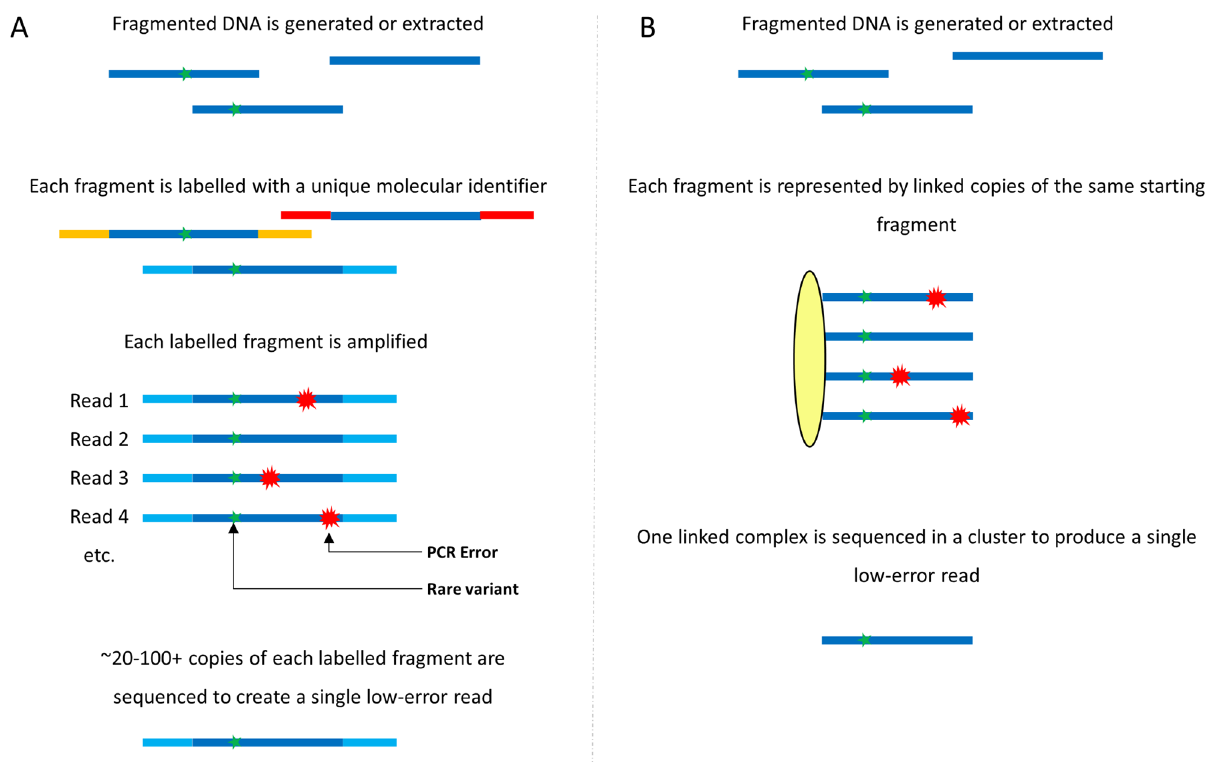
Fig 1. Barcoding vs. Pro-Seq. (A) Common molecular barcoding/UMI methods involve uniquely labeling each DNA molecule with a molecular identifier or barcode. Many copies of each barcoded molecule are sequenced, and reads from individual fragments are collected in software. True variants should be common to every read, while errors should only occur in a smaller fraction of the reads. 20 or more reads are often required to generate a software consensus for a single low-error read. (B) Pro-Seq physically links copies of the same starting fragment into a single complex. Each linked complex is then sequenced in a single cluster, producing a high-fidelity read without redundancy. Two to roughly 100 linkers have been tested with Pro-Seq, but four are shown for simplicity.